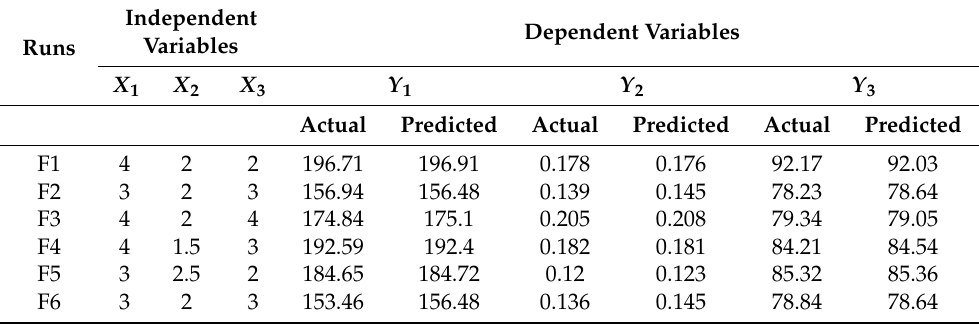
Table 2. Observed Box–Behnken experimental runs of TQ-CS-PLGA-NPs with their actual and predicted experimental values of Y 1, Y 2 , and Y 3